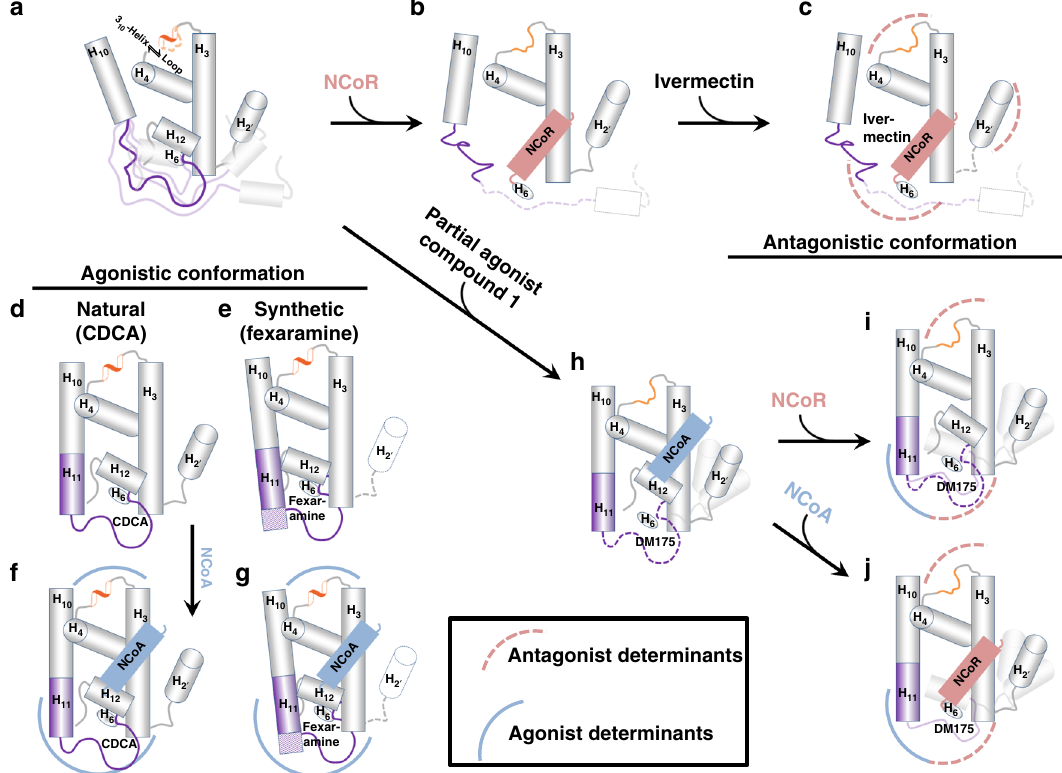
Fig. 7 Proposed model for partial agonism. Regions in the FXR-LBD structures with major changes induced upon binding of ligands (agonist, antagonist and partial agonist) are highlighted with arcs (red/dashed for antagonist characteristics, blue/bold for agonist characteristics). a In the apo FXR, the α 11 adopts a loop structure and the α 3- α 4 region predominantly exists as a loop. b Co-repressor (NCoR) binds to the apo FXR. c Antagonist binding does not induce signi fi cant structural changes, however, destabilises the α 11- α 12 (AF2-helix). The α 3- α 4 loop adopts a loop structure and the Ω -loop ( α 2 ’ - α 3 loop region) is destabilised. d Binding of the natural agonist CDCA, induces partial formation of α 11 (purple) and also the α 3- α 4 loop adopts a 3 10 — helix conformation. e Binding of the synthetic agonist fexaramine, induces extended α 11 formation (purple) and the α 3- α 4 loop adopts a 3 10 — helix conformation. f Co- activator (NCoA) binds to the CDCA bound FXR-LBD. g Co-activator (NCoA) binds to the FXR-LBD bound to fexaramine. h Binding of the partial agonist 1 , induces α 11 formation (purple), destabilises the α 11- α 12 (AF2) and the Ω -loop region. The α 3- α 4 loop adopts a loop conformation as observed for the antagonist binding. i , j Partial agonist 1 bound FXR is competent of binding either the co-activator (NCoA) or the co-repressor (NCoR)